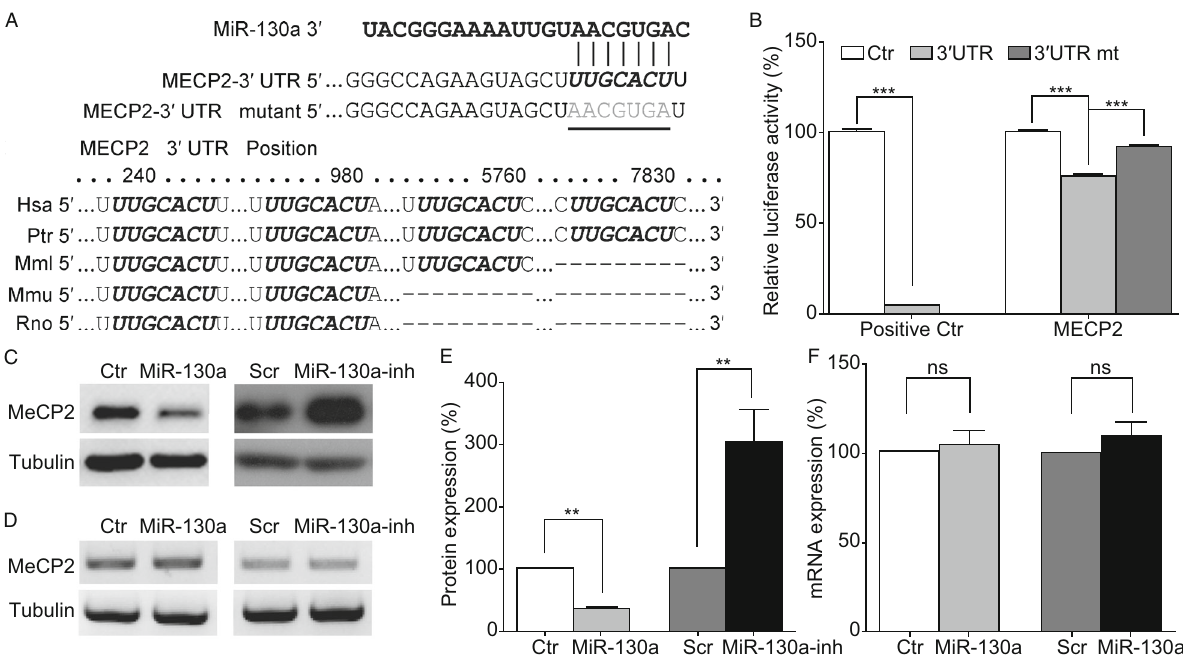
Figure 4. The MECP2 gene is a target of miR-130a. (A) Alignment of the binding sites of miR-130a on MECP2 mRNA 3 ′ UTR. The seed regions of miR-130a binding sites are in italics. Luciferase reporter plasmids containing the human MECP2-3 ′ UTR regions, either the wild type UTR (MECP2-3 ′ UTR) or the mutant UTR with the most highly conserved binding site for miR-130a mutated as shown (MECP2-3 ′ UTR mutant). (B) A dual luciferase reporter assay. Relative luciferase activity was measured in HEK293 cells at 48 h post-transfection. The wild-type MECP2-3 ′ UTR is referred to as “ 3 ′ UTR ” , whereas the mutant described in panel (A) is indicated as “ 3 ′ UTRmt ” . (C) The MeCP2 protein levels as detected by Western blotting. Rat E18 cortical neurons were electroporated with the control vector, miR-130a, scramble RNA (Scr) or miR-130a inhibitor (miR-130a-inh). β -Tubulin was used as an internal control. (D) The MeCP2 mRNA levels as assayed by RT-PCR with β -tubulin as an internal control. (E and F) Quanti fi cation and statistical analysis of data in (C) and (D). The bar diagram represents mean values ± SEM. Data represent three independent